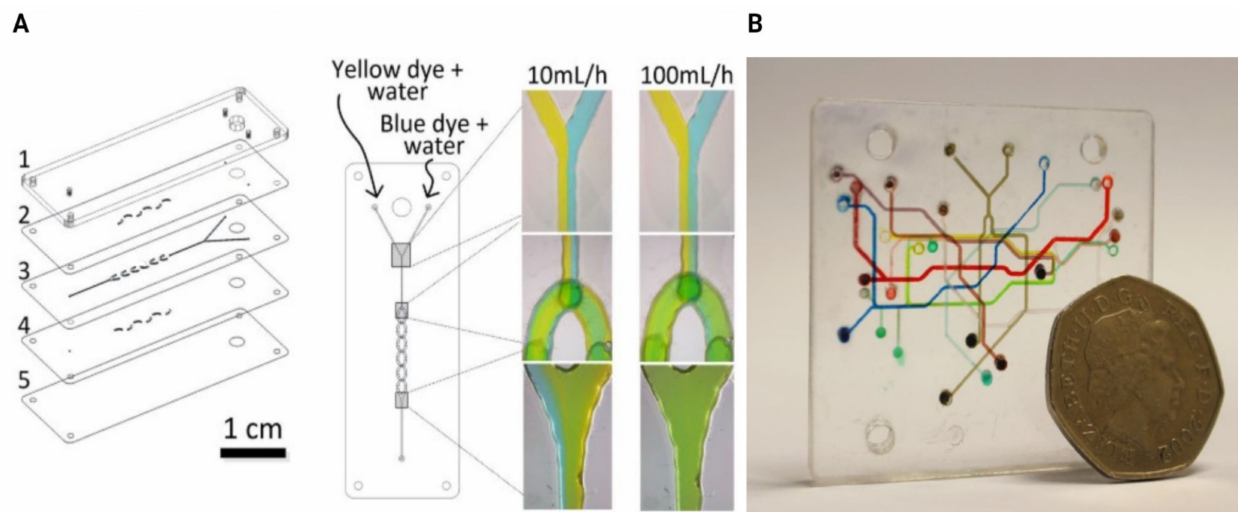
Figure 4. Laminated microfluidics created by stack of polymethylmethacrylate (PMMA) layers structured using laser cutting and joining using ethanol-assisted thermal bonding. ( A ) Five-layer split and recombine micromixer. ( B ) Nineteen-layer London underground map against a UK 50 pence coin from [129] under Creative Commons 4.0 International